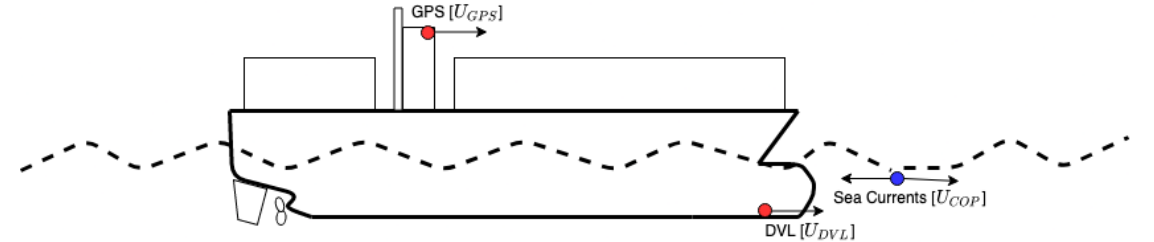
Figure 1. Locations where the three speed signals of interest derive from. Red is used to indicate ship sensors and blue for